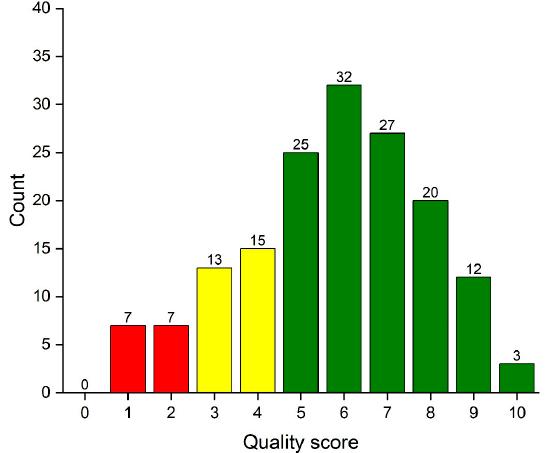
Figure 1. Column graph of the data analysis reporting quality score of 160 articles. Articles with poor quality (0–2) are denoted with red column color, those with weak quality (3–4) with yellow color and at least acceptable (5–10) articles with green color.